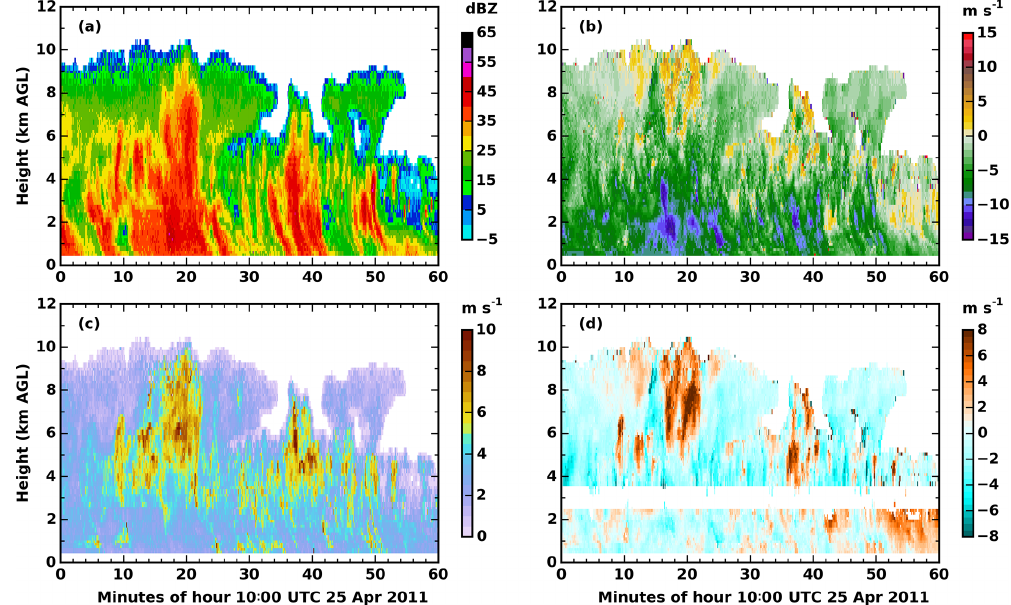
Figure 3. UAZR-C1 observations on 25 April 2011: (a) reflectivity, (b) Doppler velocity, (c) spectrum width, and (d) corresponding vertical air motion retrieval. Within the melting layer (2.5–3.5kma.g.l.) no vertical air motion retrieval was